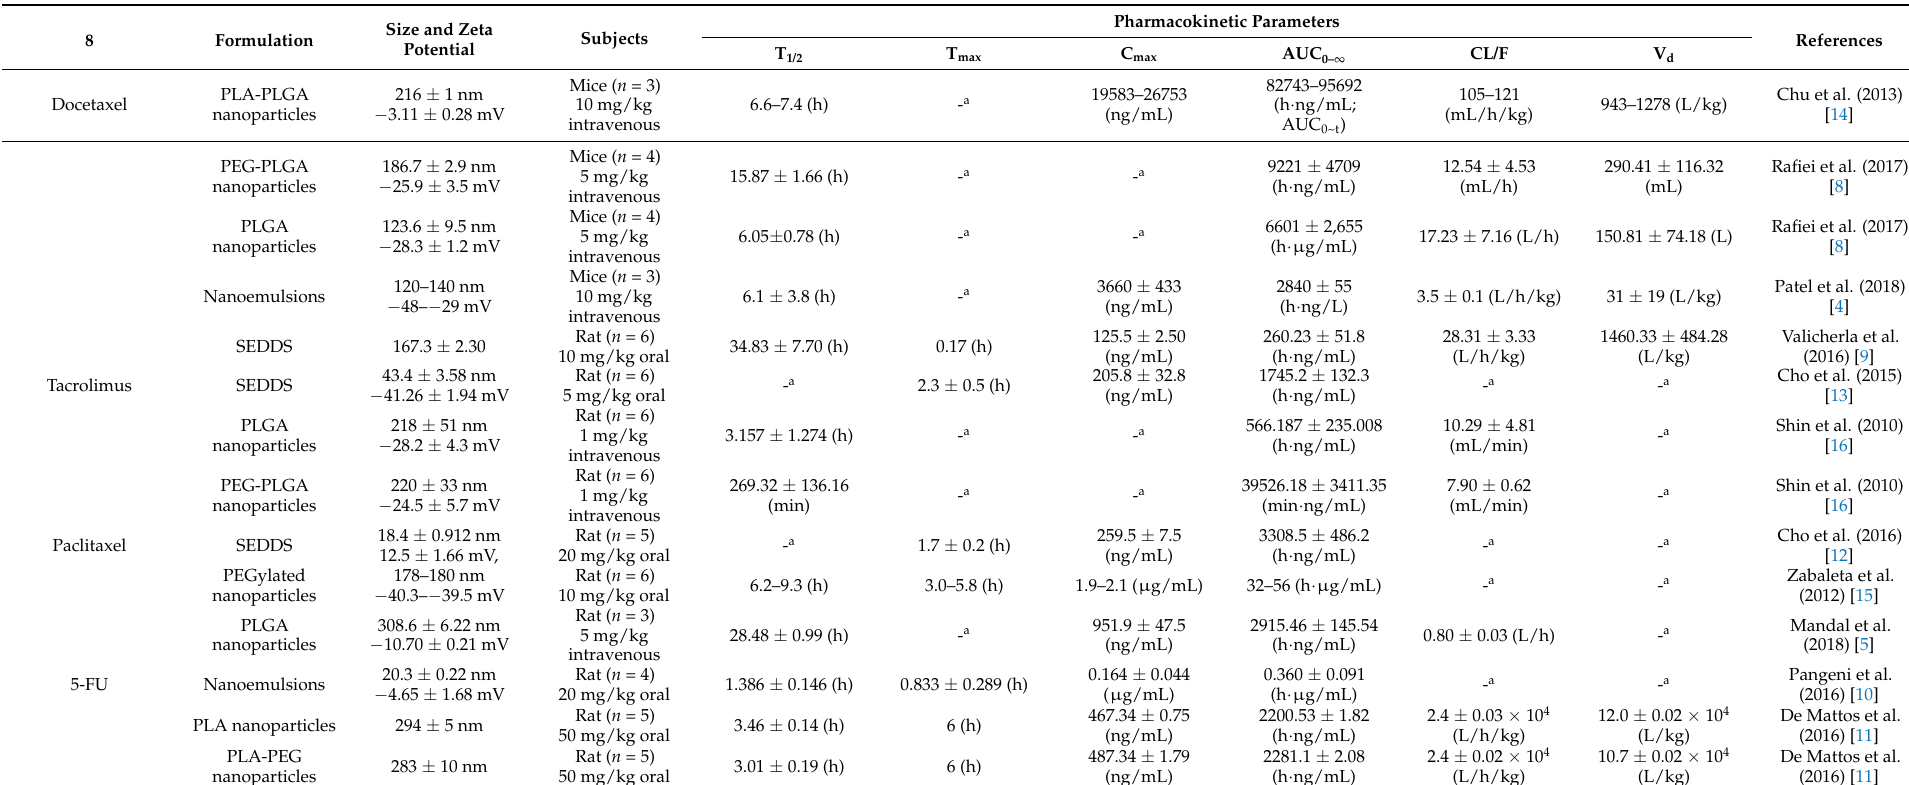
Table 11. Summary of pharmacokinetic data of previously reported nanoparticles and nanoemulsion